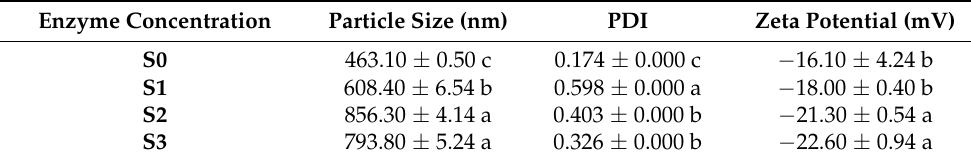
Table 1. Average particle size, Zeta potential, and PDI value of EPI cross-linked under different enzyme concentrations ( n =